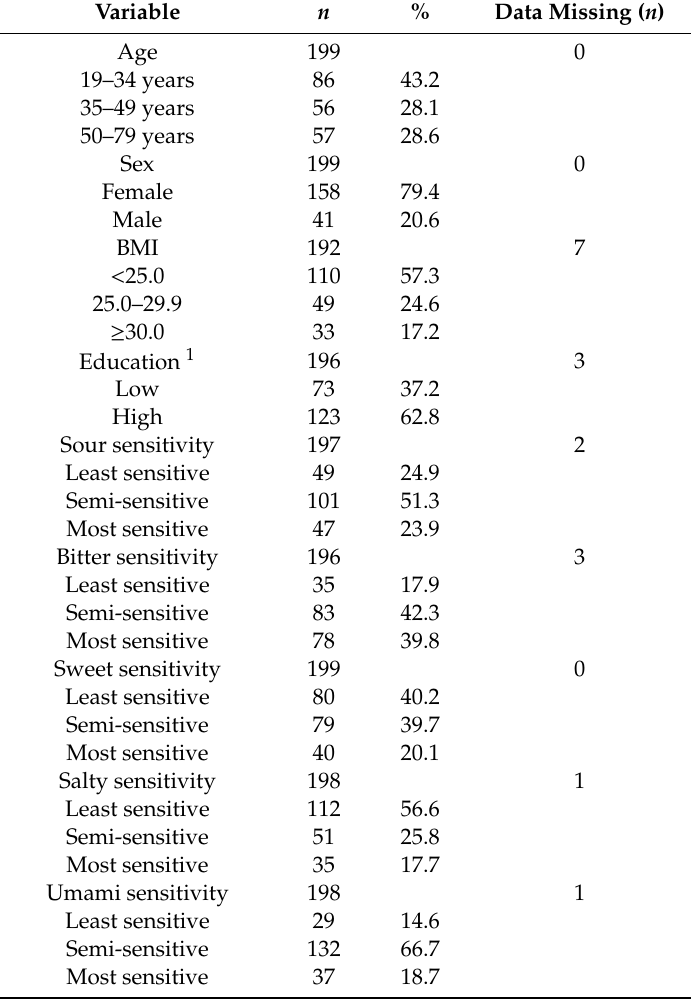
Table 2. Subjects’ characteristics ( N = 199).